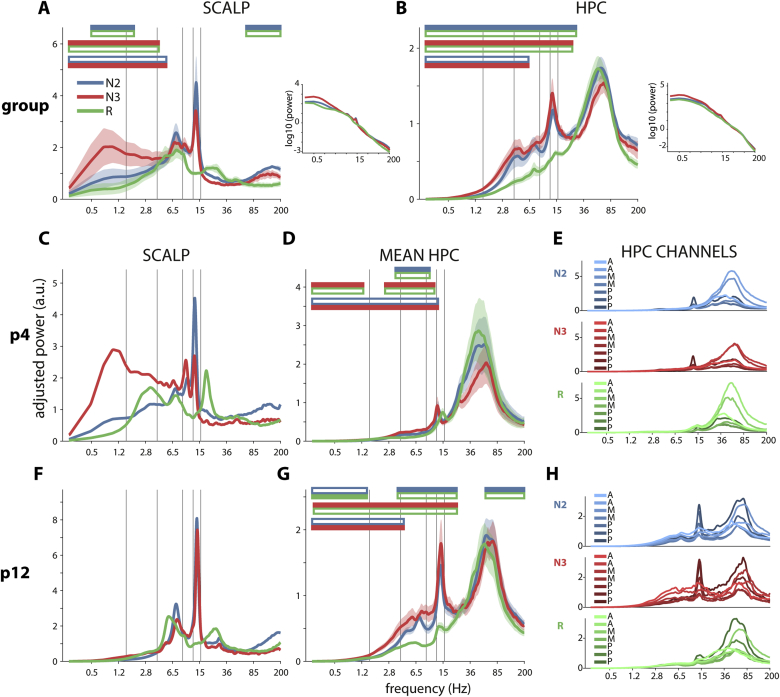
Scalp (Cz) and hippocampal sleep spectra. Top: Group-level spectra averaged across all 12 patients at the scalp (A) and in HPC (B). Error shading: standard error of the mean across patients. Horizontal color bars above plots indicate significant (P < 0.05) pairwise stage differences (cluster-based permutation test). Filled color reflects stage with greater power. Gray vertical lines at 1.5, 4, 9, 12.5 and 16 Hz indicate approximate boundaries between SO, delta, theta, slow spindle, fast spindle, and faster activity. Right panels in (A) and (B) show same spectra without slope removal. The flattening of the raw spectrum at low (<4 Hz) frequencies results in comparatively low adjusted power after slope removal. Middle/bottom: Spectra of two example patients highlight differences between individuals, both at the scalp (C and F) and in HPC (D and G; error shading: standard error of the mean across data segments; stage differences as above). A further breakdown by HPC channel (E and H) reveals spectral differences along the longitudinal HPC axis (A: anterior [lighter color]; M: middle; P: posterior [darker color]; 7 HPC channels for both patients).